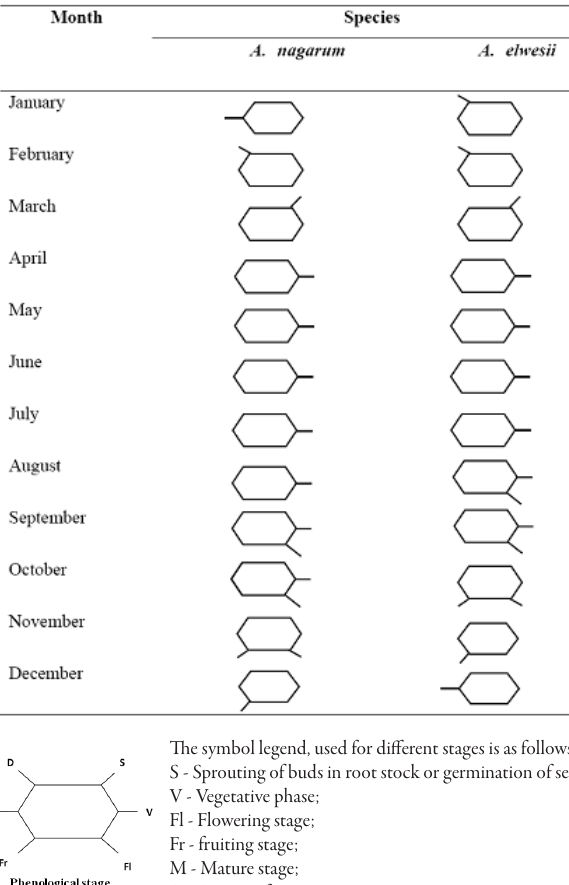
Tab. 1. Phenogram of Aconitum spp.